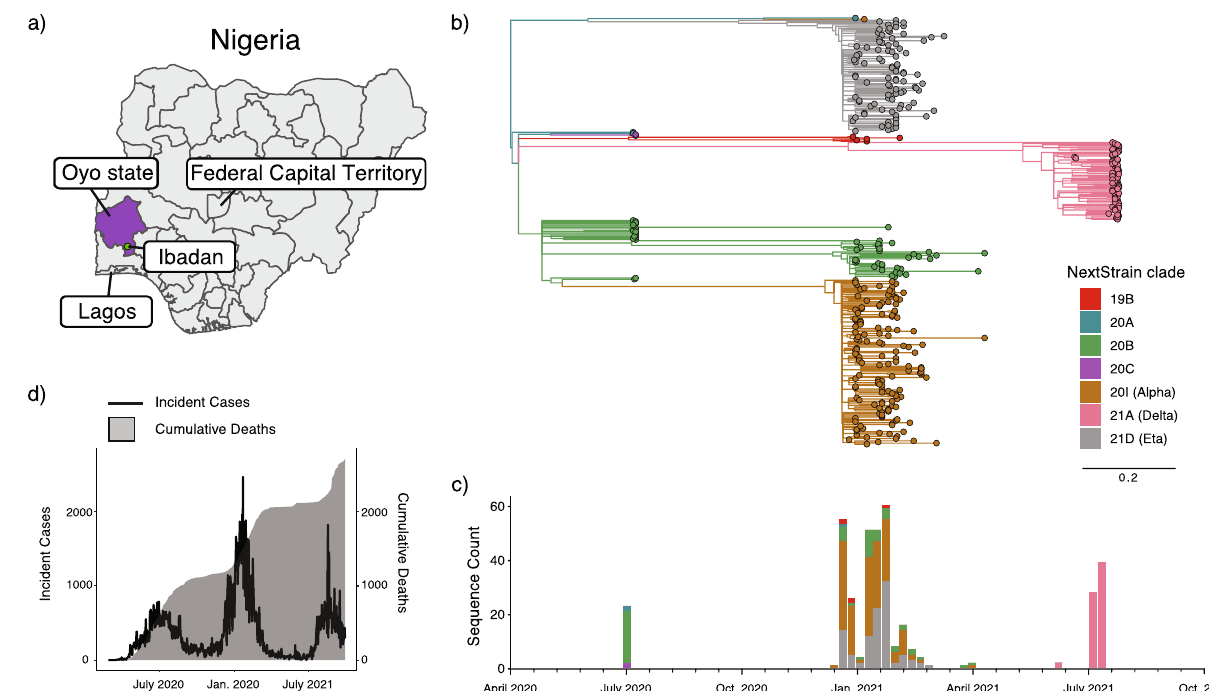
Fig. 1 Phylogenetic analysis of SARS-CoV-2 isolates in Oyo state. a Geographical location of Oyo state, Nigeria is indicated (purple), where the sampling for this study was performed. b ML phylogenetic tree of 378 SARS-CoV-2 specimen genomes in Oyo state collected between 12 July 2020 and 3 August 2021. Clades following Nexclade nomenclature are indicated and colored. Scale indicates the number of substitutions per site and time. c Distribution of the different clades per time found in the Oyo dataset reported here. d Evolution of daily COVID-19 incidence and cumulative daily COVID-19-related